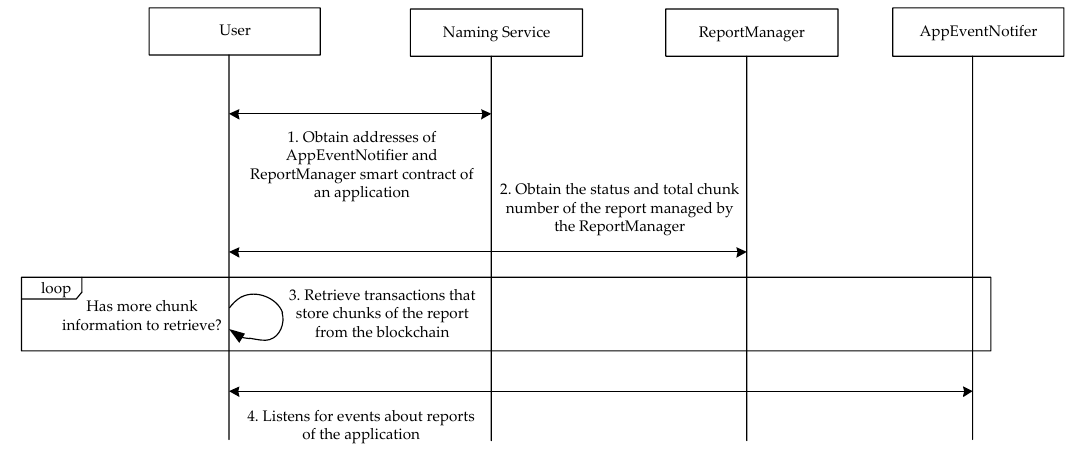
Figure 9. The report query process.